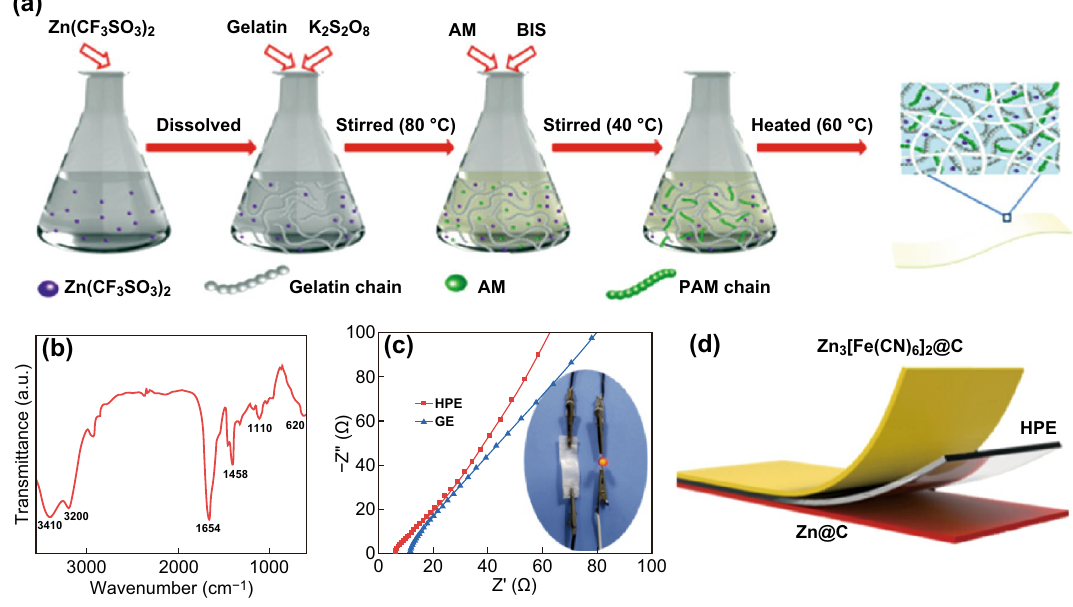
Fig. 2 a Synthesis route scheme of HPE electrolyte. b FTIR spectrum of the gelatin-g-PAM HPE treated by lyophilization. c EIS comparison of HPE and pristine GE in the frequency range from 10 kHz to 0.01 Hz, attached is the demonstration of electrolyte conduction. d Schematic illus- tration of the flexible aqueous ZIB with sandwich